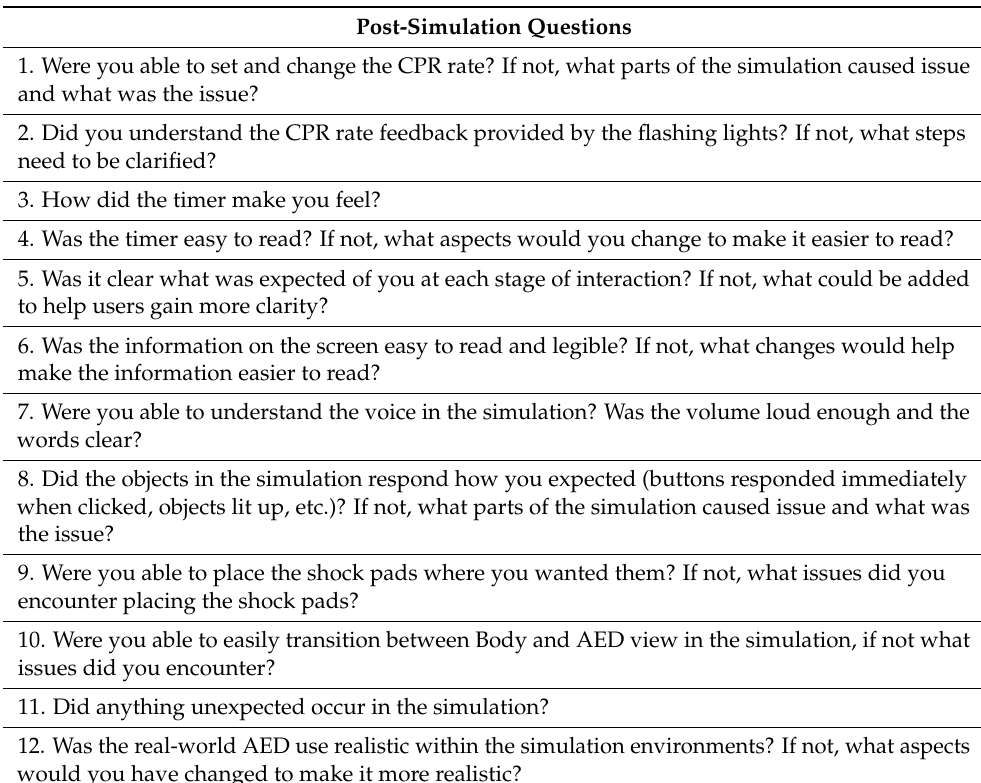
Table 3. List of post-simulation survey